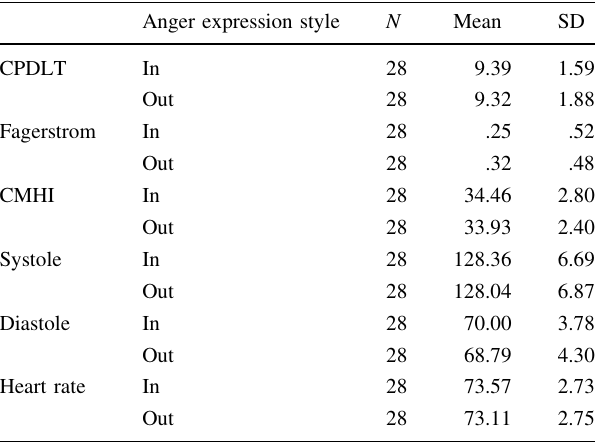
Fig. 2 RFFT systolic blood pressure, group by time